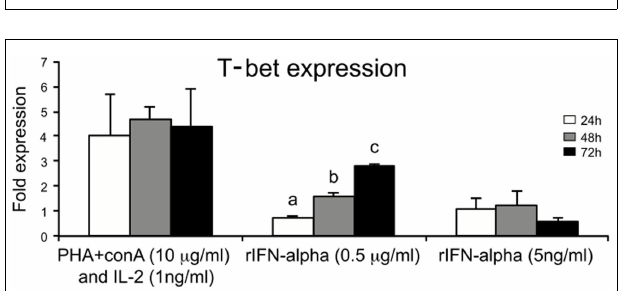
FIGURE 5 | Tissue distribution of T-bet expression in healthy Atlantic salmon . Expression of salmon T-bet in different organs by real-time PCR. Gene expression data were normalized to EF-1 α expression using liver as a calibrator. Bar represents the mean ± SEM ( n = 6). Asterisk (*) above the bar shows significant difference ( P < 0.05) compared with the organ that showed the lowest expression (liver). The value above the bars shows average real-time CT values of six fish.